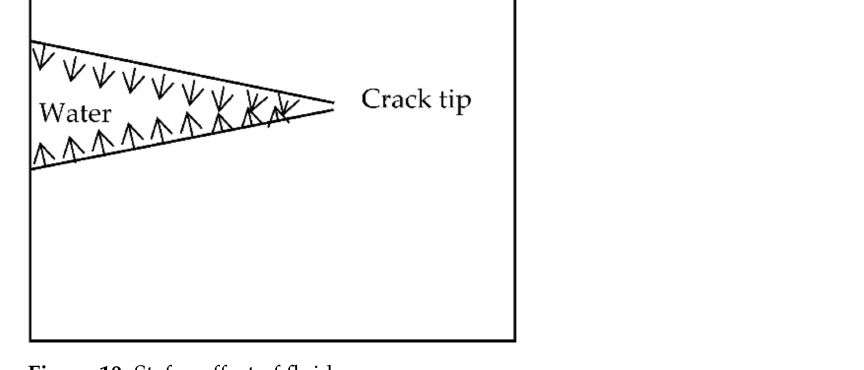
Figure 10. Stefan effect of